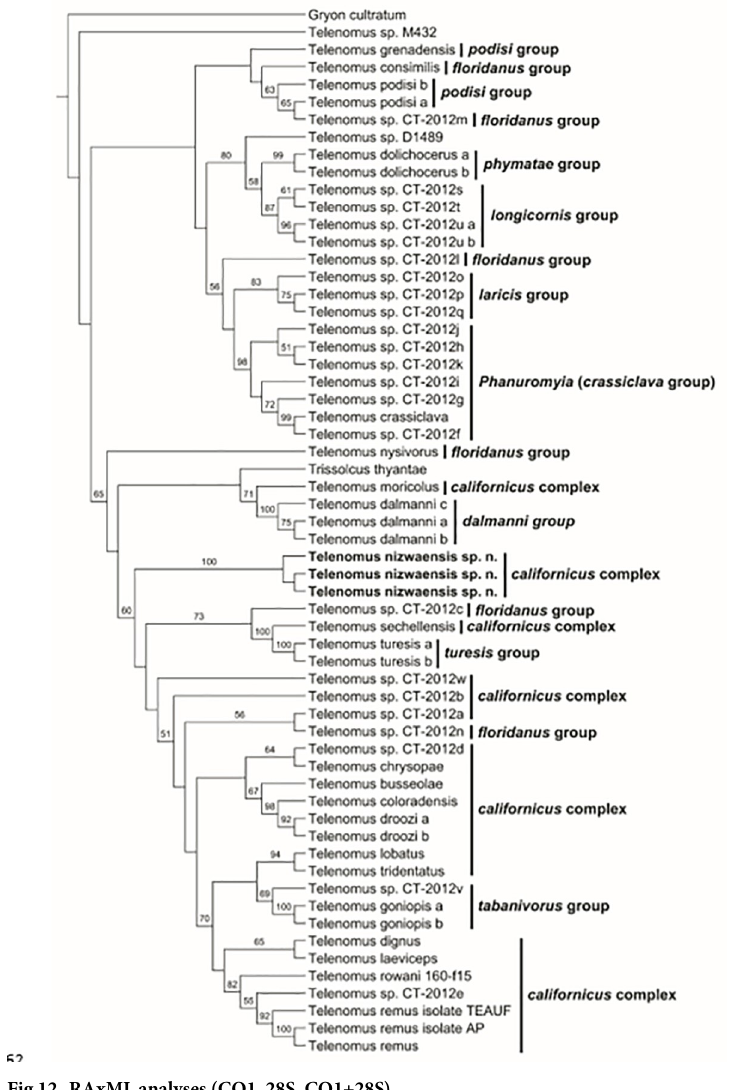
Fig 12. RAxML analyses (CO1, 28S,